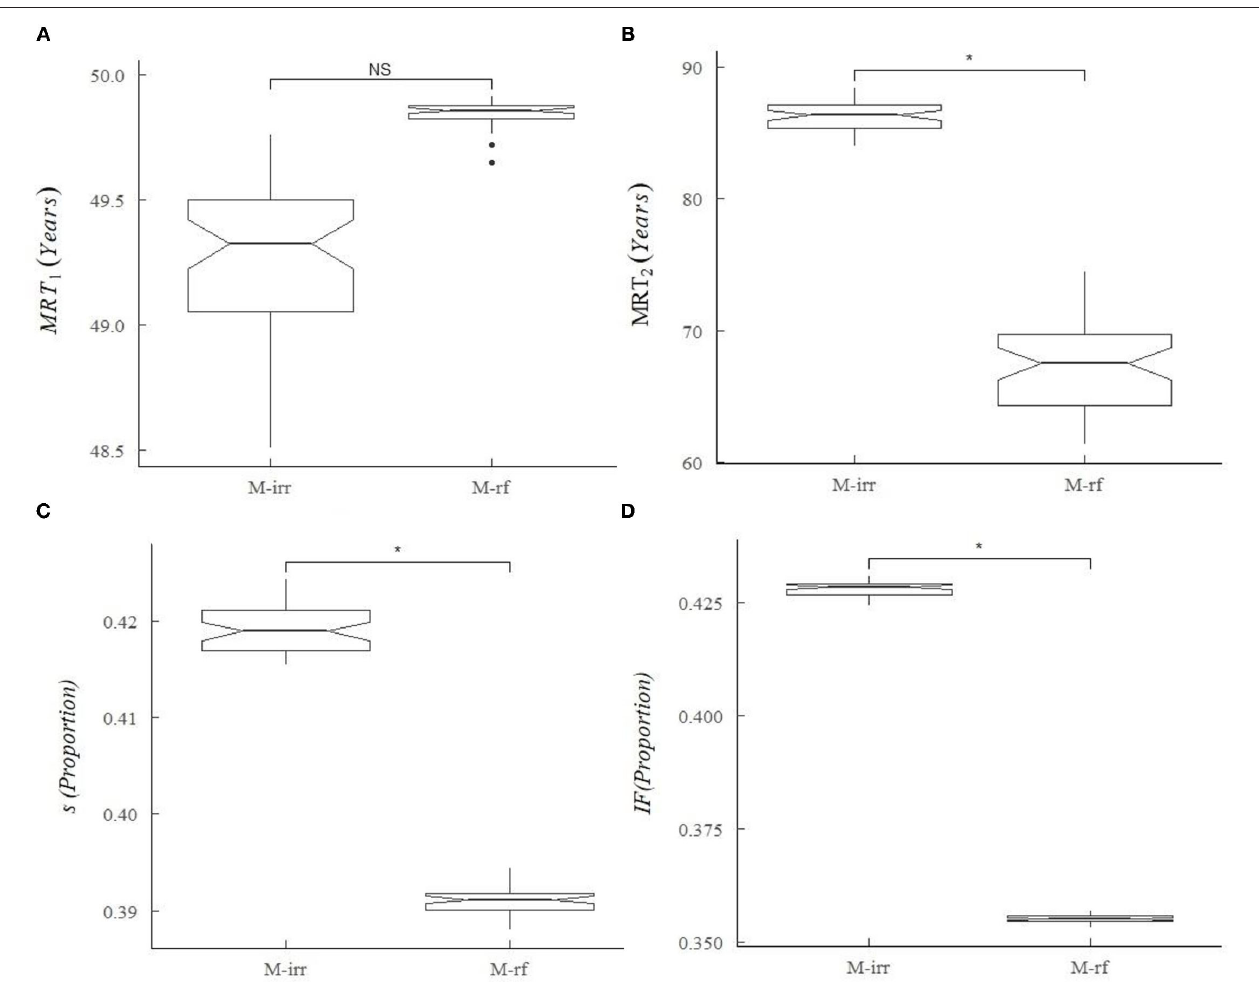
FIGURE 8 | Fifty best sets of parameters obtained for the parallel model with the GLUE procedure. Values of MRT 1 (A) , MRT 2 (B) , the split s parameter (C) , and the proportion from crop residues incorporated into the soil ( IF ) (D) in the parallel model for rainfed maize (M-rf) and irrigated maize (M-irr). The boxplots represent the median ( n = 50), 25th and 75th percentiles with the whiskers extending to the most extreme data points within the 1.5 × of values generated by the model for each parameter. *Represents significant differences (no overlapping of the intervals of possible model